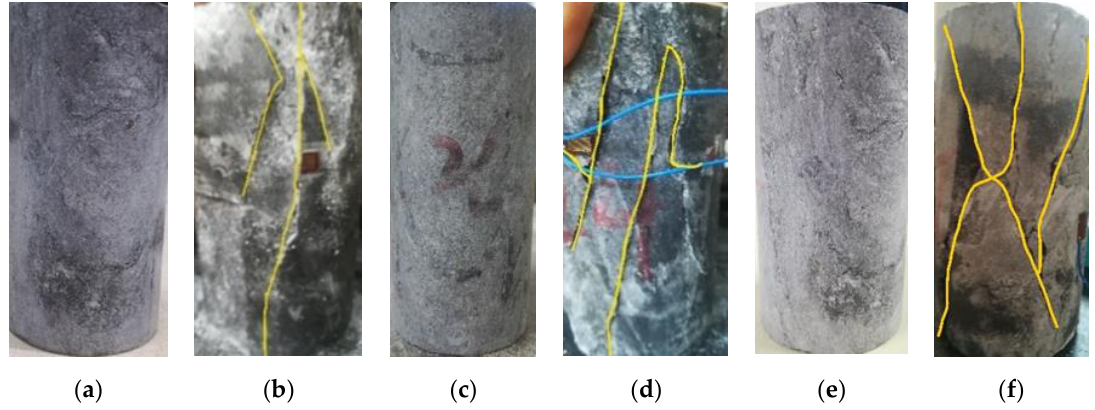
Figure 5. Macroscopic structure of rocks before and after tests under different loading rates: ( a ) before test under v = 0.15 mm/min; ( b ) after test under v = 0.15 mm/min; ( c ) before test under v = 0.2 mm/min; ( d ) after test under v = 0.2 mm/min; ( e ) before test under v = 0.3 mm/min; ( f ) after test under v = 0.3 mm/min.